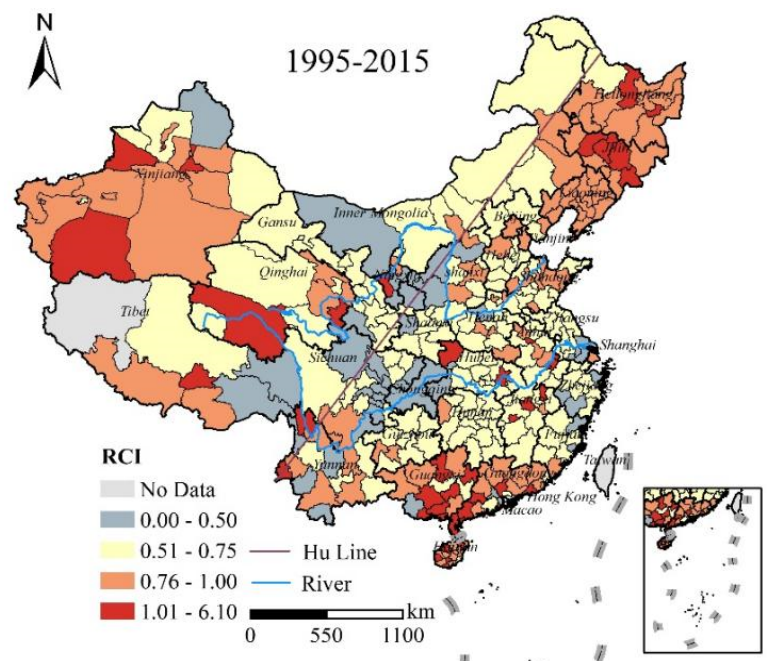
Figure 2. Rural settlement capacity index values in China 1995–2015.